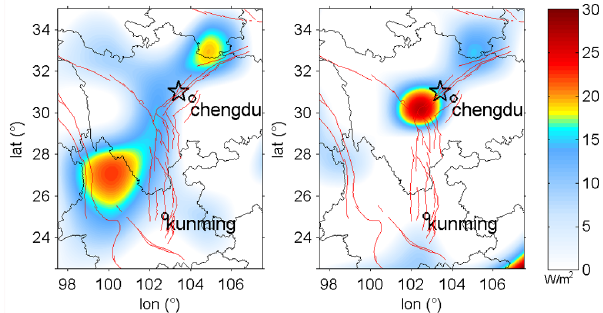
Fig. 2. OLR variation over Sichuan-Yunnan region in April (left) and May (right), 2008 (epicenter is marked with star, active faults with red